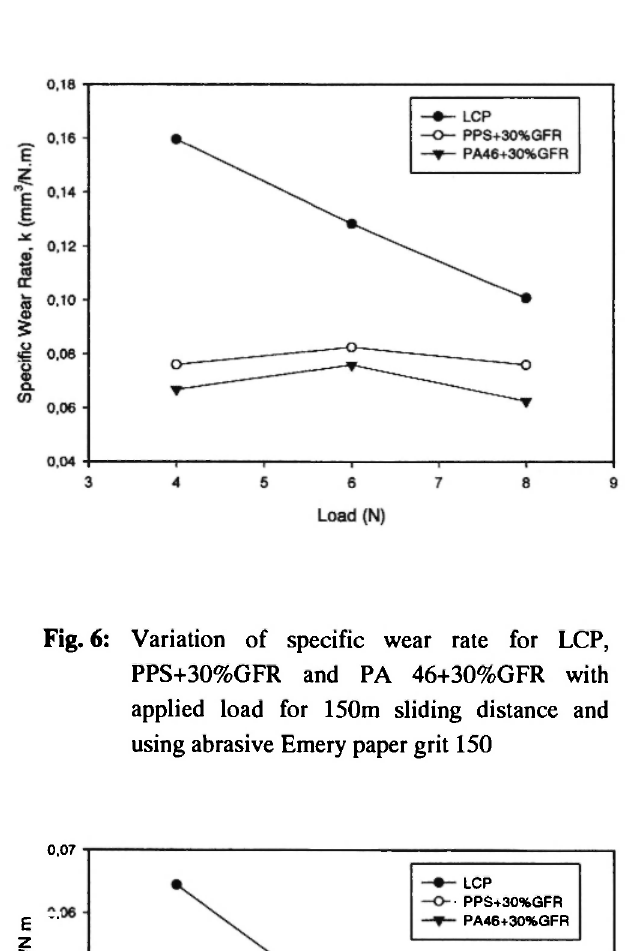
Fig. 7: Variation of specific wear rate for LCP, PPS+30%GFR and PA 46+30%GFR